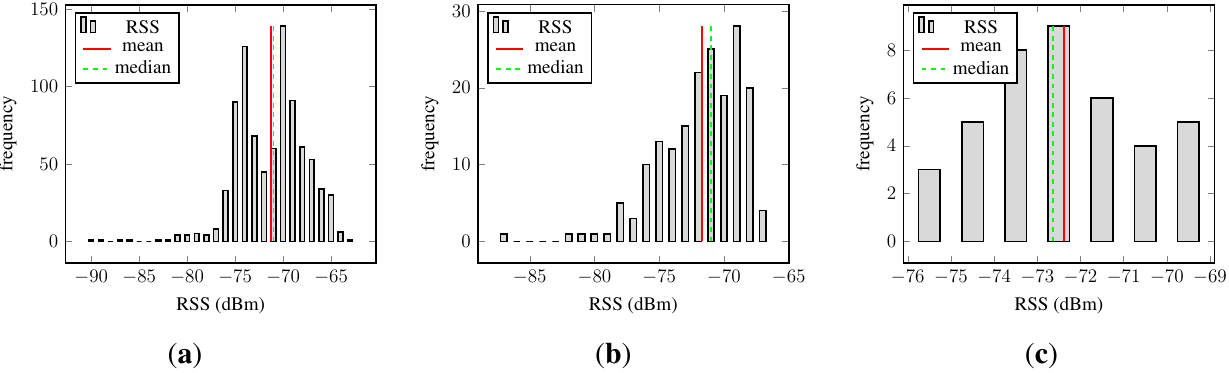
Figure 2. Received signal strength (RSS) histograms at a fixed location: ( a ) Histogram of RSS; ( b ) histogram of RSS averaged over one second; ( c ) histogram of RSS averaged over five seconds. The mean and median are marked by vertical